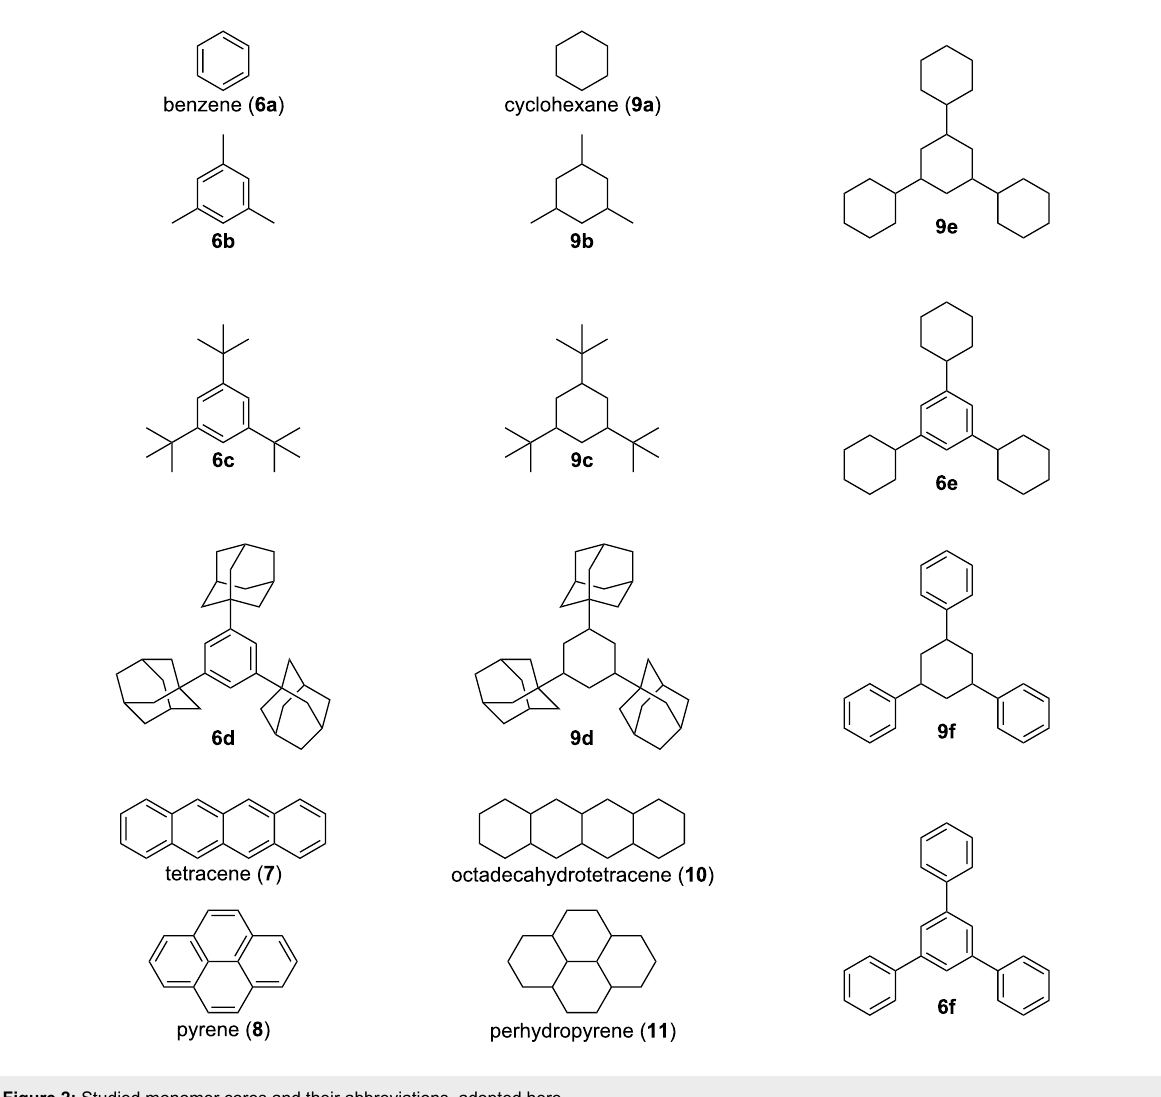
Figure 2: Studied monomer cores and their abbreviations, adopted here.